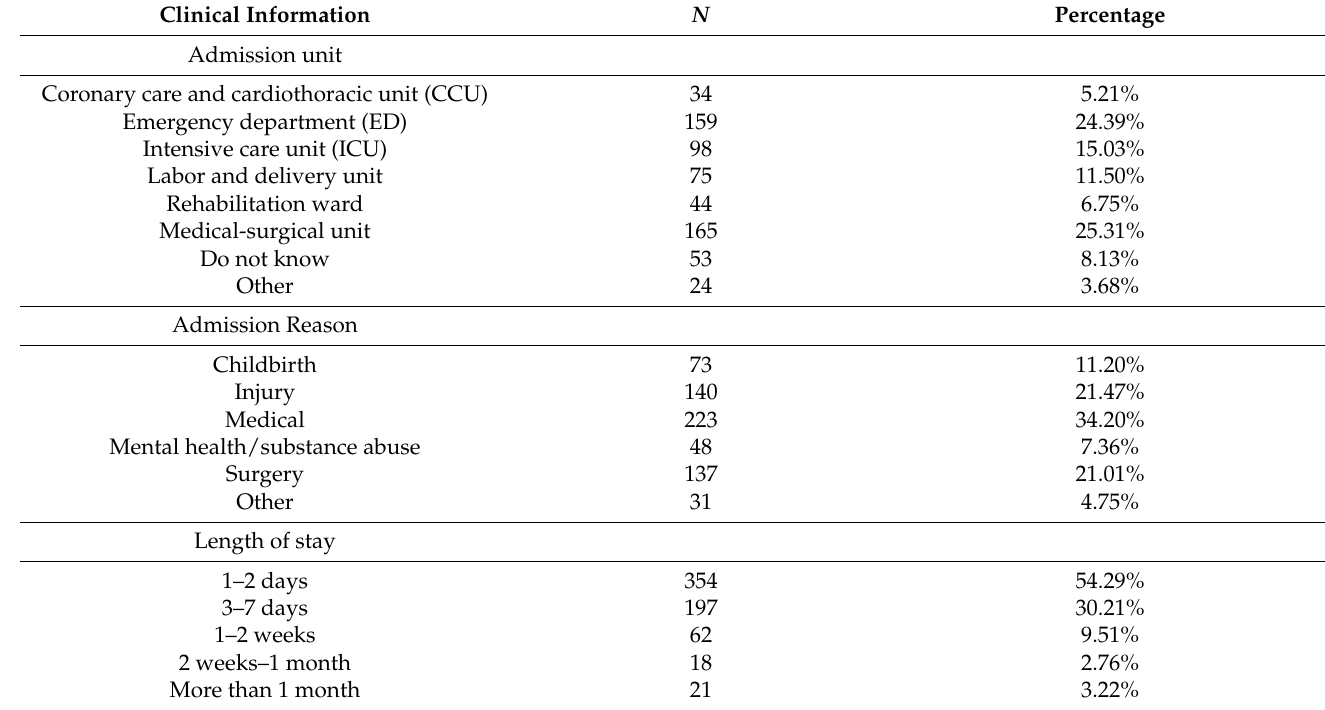
Table 2. Clinical information for patients’ hospital